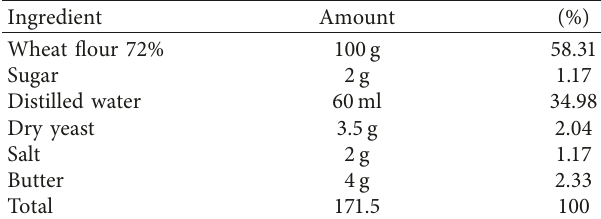
Table 1: Standard formula for bread preparation.